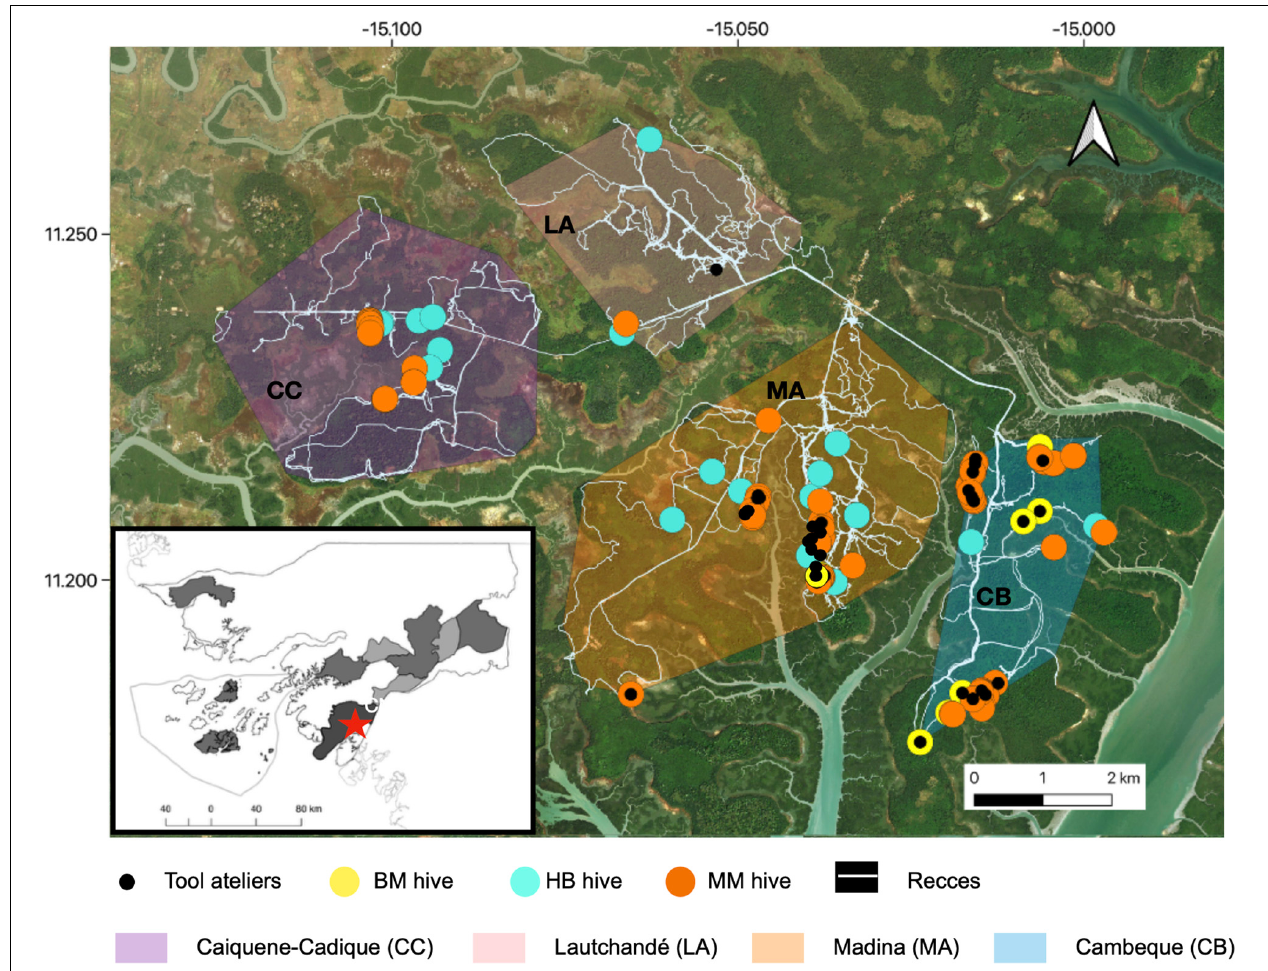
FIGURE 1 | Map of the study site showing each of the study communities’ estimated core home range. CNP is marked by a red start, Caiquene-Cadique is shown in purple, Lautchandé in pink, Madina in orange and Cambeque in blue. Ranging areas during the study period were estimated using minimum bounding polygon from 4293 direct (chimpanzee encounters and camera trap data) and 1796 indirect (nests, feeding traces and faecal samples) data points, collected during reconnaissance walks from February 2017 to July